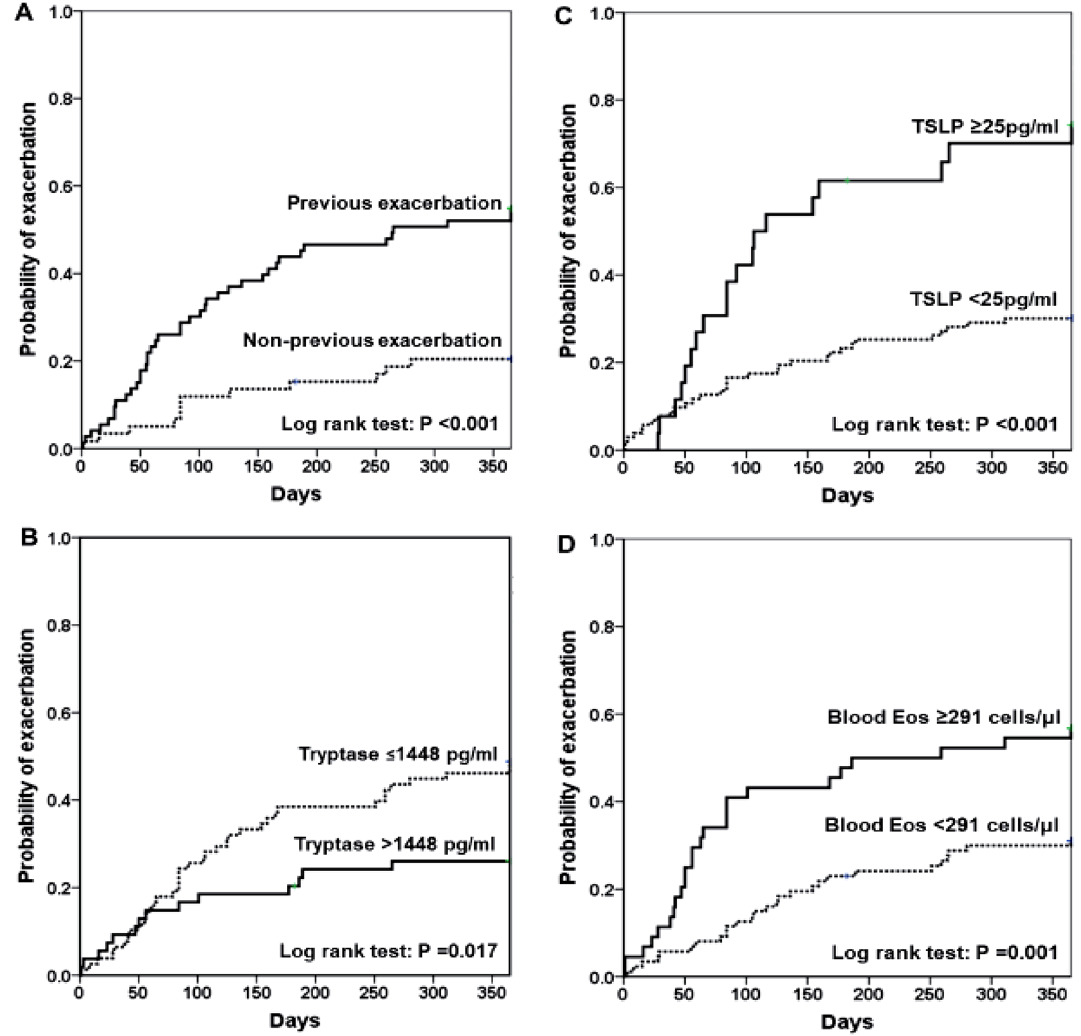
Figure 1. Kaplan–Meier curves of the cumulative probability of exacerbation during the 1-year follow-up period stratified by previous history of asthma exacerbation ( A ), serum tryptase ( B ) and TSLP ( C ) levels, and blood eosinophil count ( D ). The cut-off values of 1448 pg/mL, 25 pg/mL, and 291 cells/µL for serum tryptase level, serum TSLP level, and blood eosinophil count, respectively, were chosen by receiver operating characteristic curve